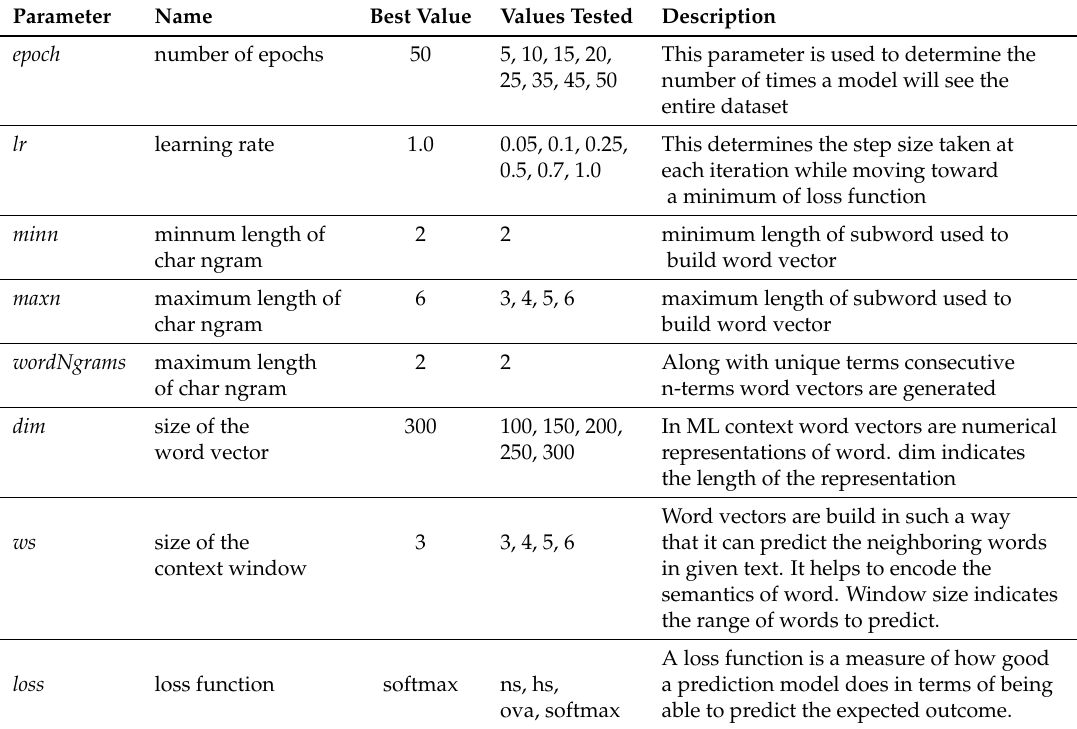
Table 4. fastText hyperparameters and values tested for tuning the model.